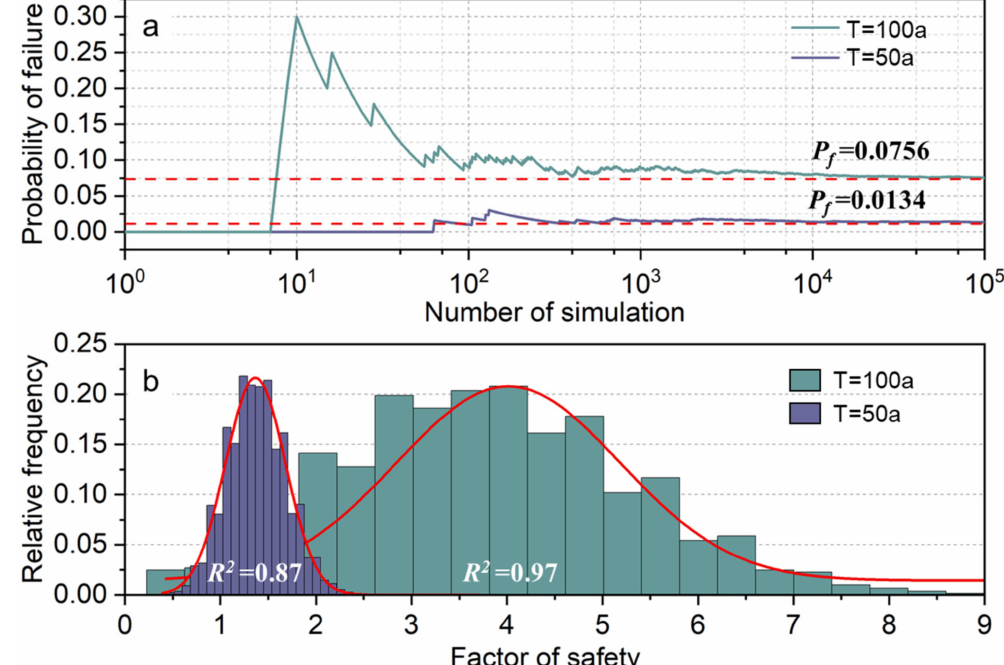
Figure 13. Monte Carlo simulation results under two rainfall conditions: ( a ) average failure probability vs. number of simulations; ( b ) histogram of the safety